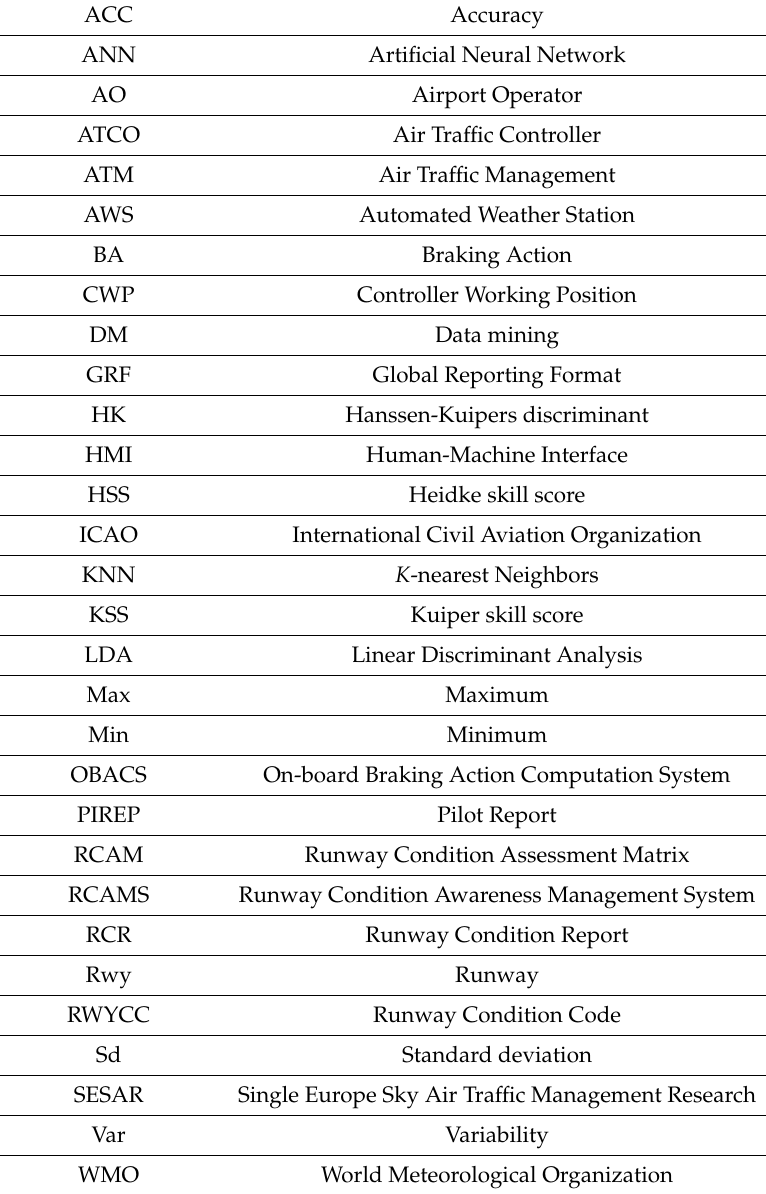
Table A2. List of